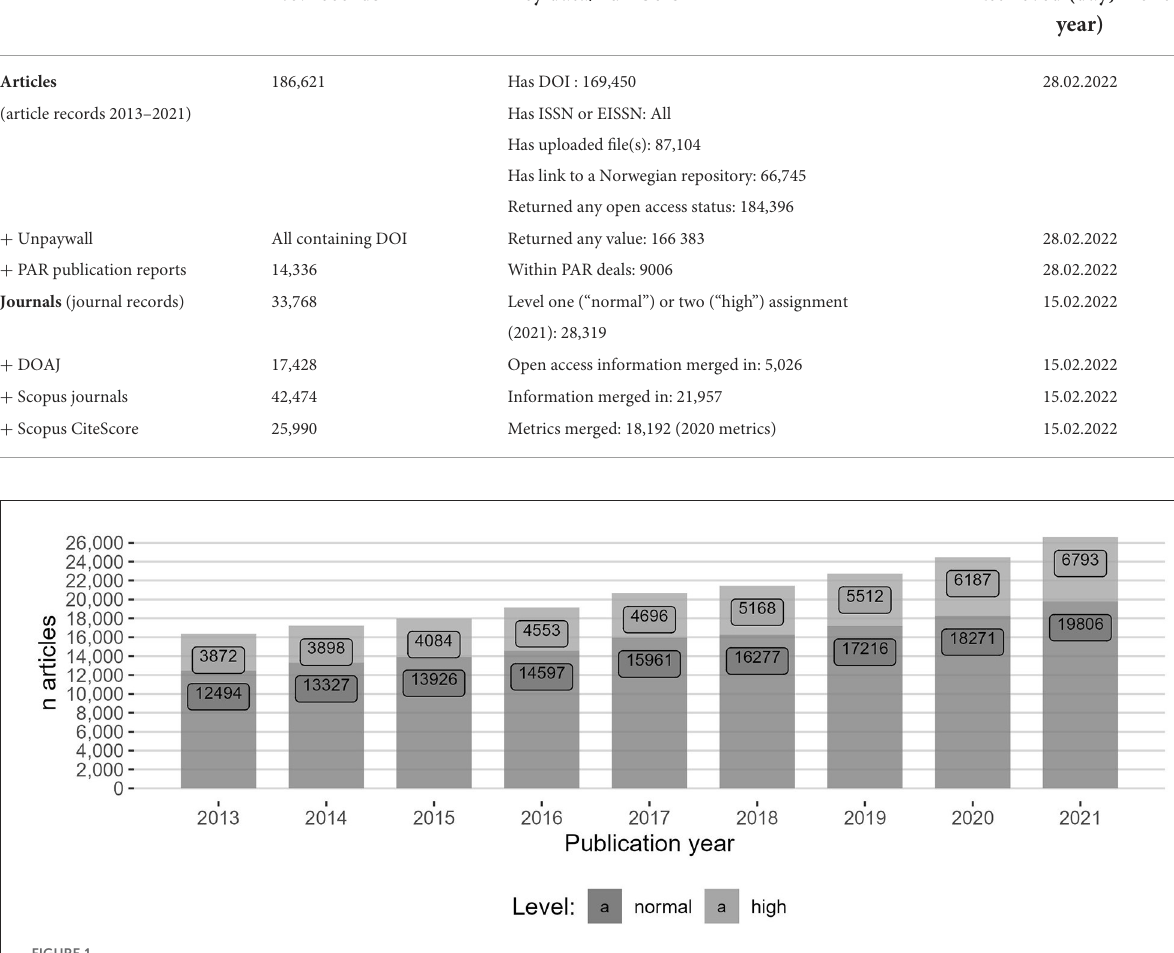
section. The dataset used in the study is made available at doi: